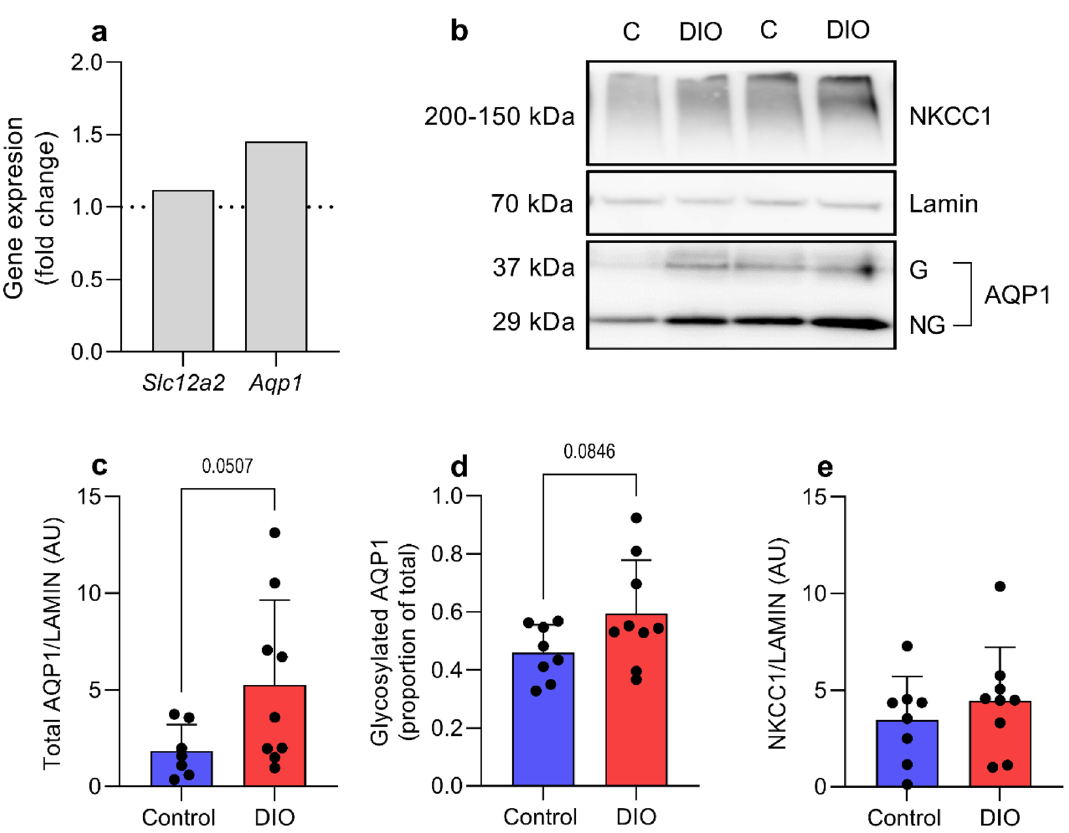
Figure 5. Expression of AQP1 and NKCC1 at CP. Expression of NKCC1 and AQP1 at CP in female Sprague– Dawley rats on control and HFD after 30 days implant with telemetric probes. Fold change of mRNA expression of NKCC1 and AQP1 in CP ( a ). Representative cropped western blots of two gels ran in parallel, where samples were derived from the same experiment (see supplementary 1–3 for raw blots) ( b ). Protein expression of AQP1 ( c ), proportion of glycosylated AQP1 ( d ) and NKCC1 protein expression (e ). Dotted line represent mean for controls in ( a ). Unpaired students t-test is done for ( a,c,d,e ). Data presented as geometric mean for ( a ) and mean + SD for ( c–e ). N =